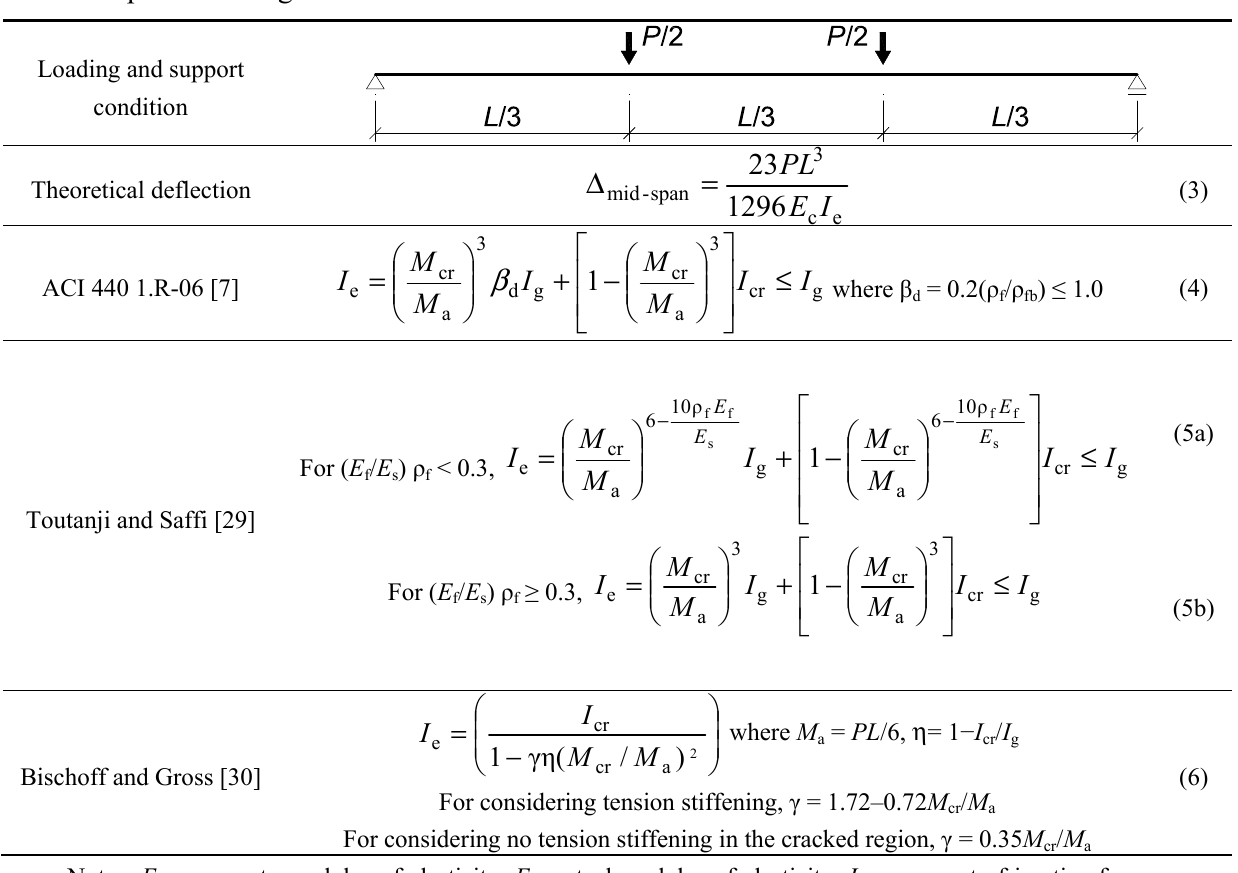
Table 3. The equivalent moment of inertia ( I four-point